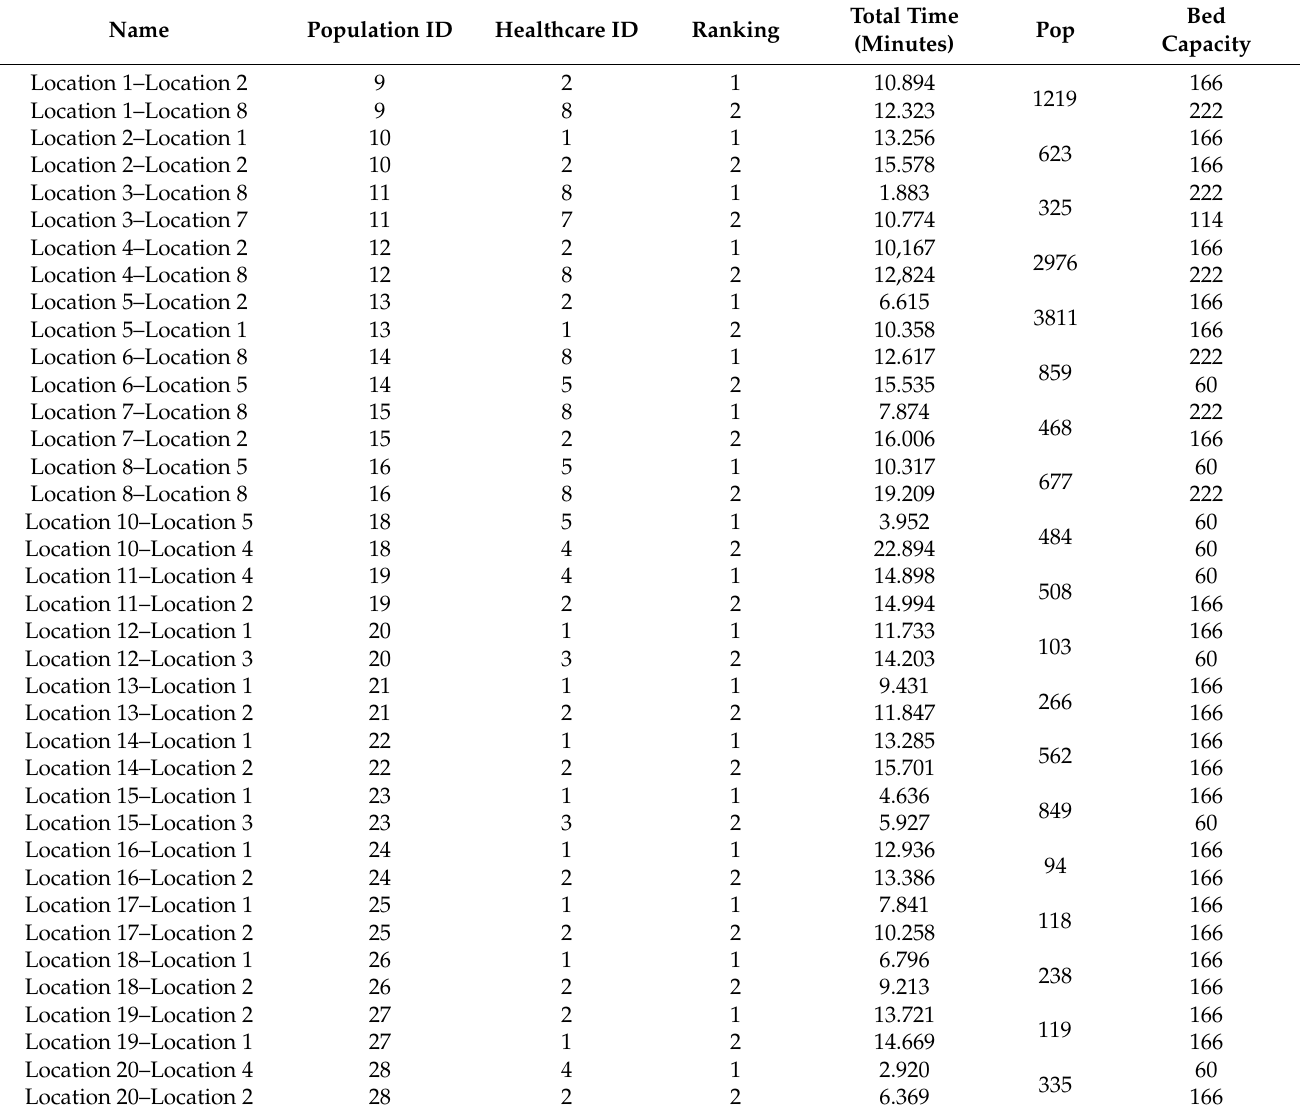
Table 6. Evacuation route time, population (Pop), and healthcare capacity before